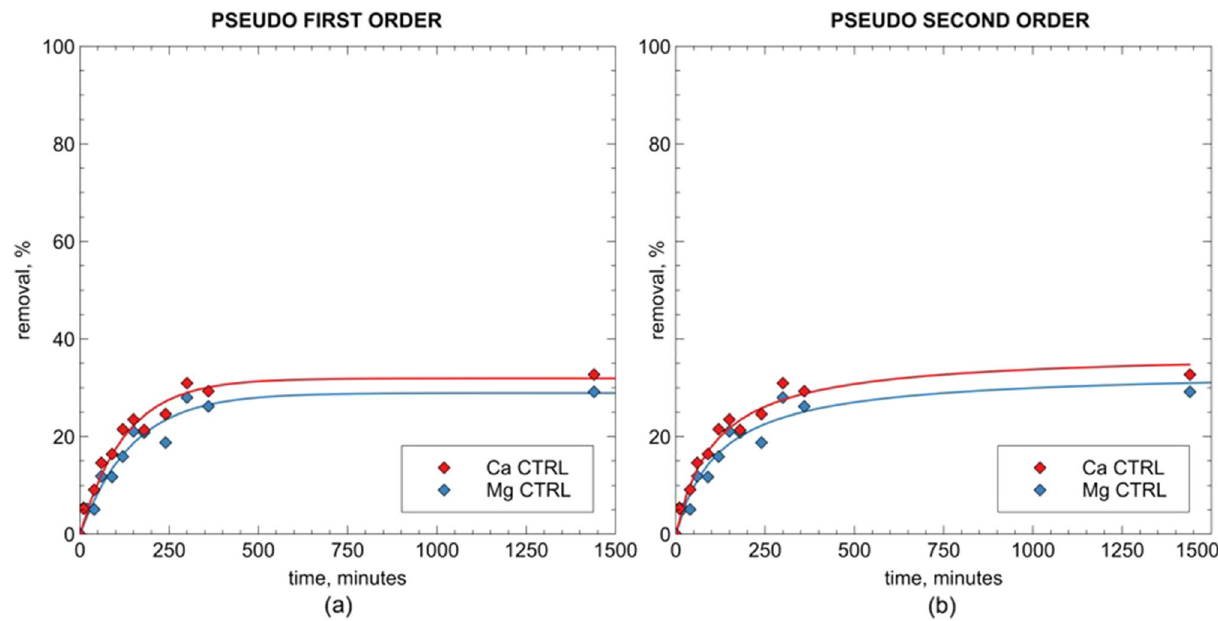
Figure 7. Modeling results for calcium and magnesium kinetic curves for ZEOP sample under controlled pH conditions (pH =